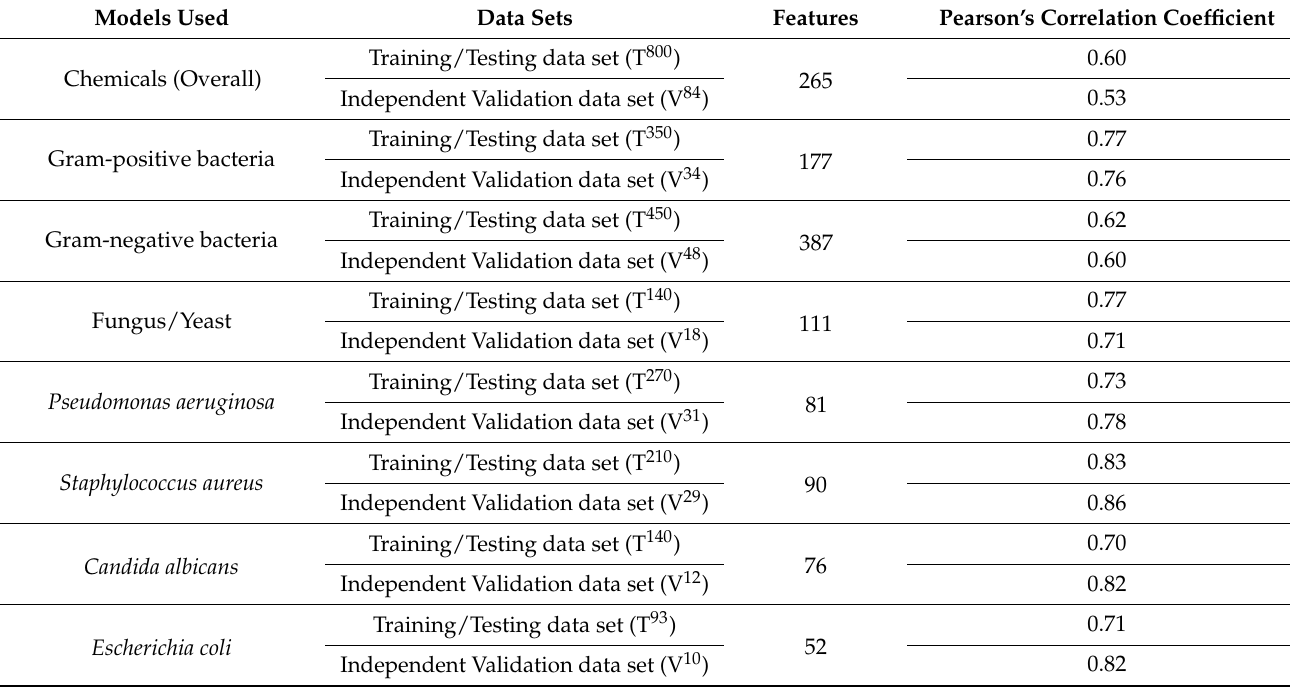
Table 1. Performance of all the eight predictors (both training/testing and independent validation) using a regression-based approach developed using the support vector machine method, along with the final descriptors employed